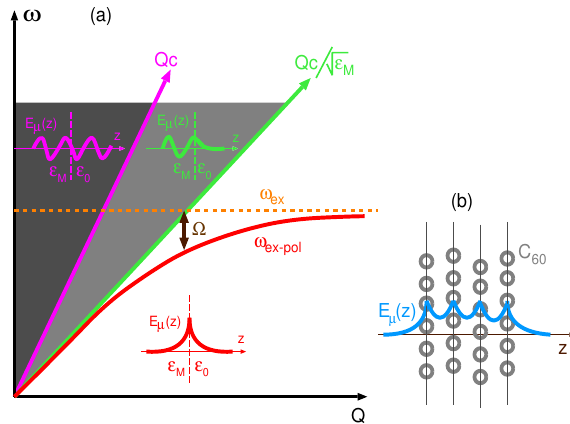
Figure 2. ( a ) The character of the electromagnetic modes at the dielectric/vacuum ( (cid:101) M / (cid:101) 0 ) interface. In the region ω > Qc , the electromagnetic modes are entirely radiative (both in vacuum and in the √ (cid:101) M < ω < Qc , they are radiative in the dielectric and evanescent in dielectric), in the region Qc / √ (cid:101) M region, they have fully evanescent character. In the latter region, vacuum, and in the ω < Qc / the photon and molecular exciton ( ω ex ) hybridize, and an exciton–polariton ( ω ex-pol ) occurs. The measure of the coupling strength between the exciton ω ex and the photon is given by Rabi splitting Ω . ( b ) The evanescent electric field E µ ( z ) produced by an exciton–polariton in the C 60